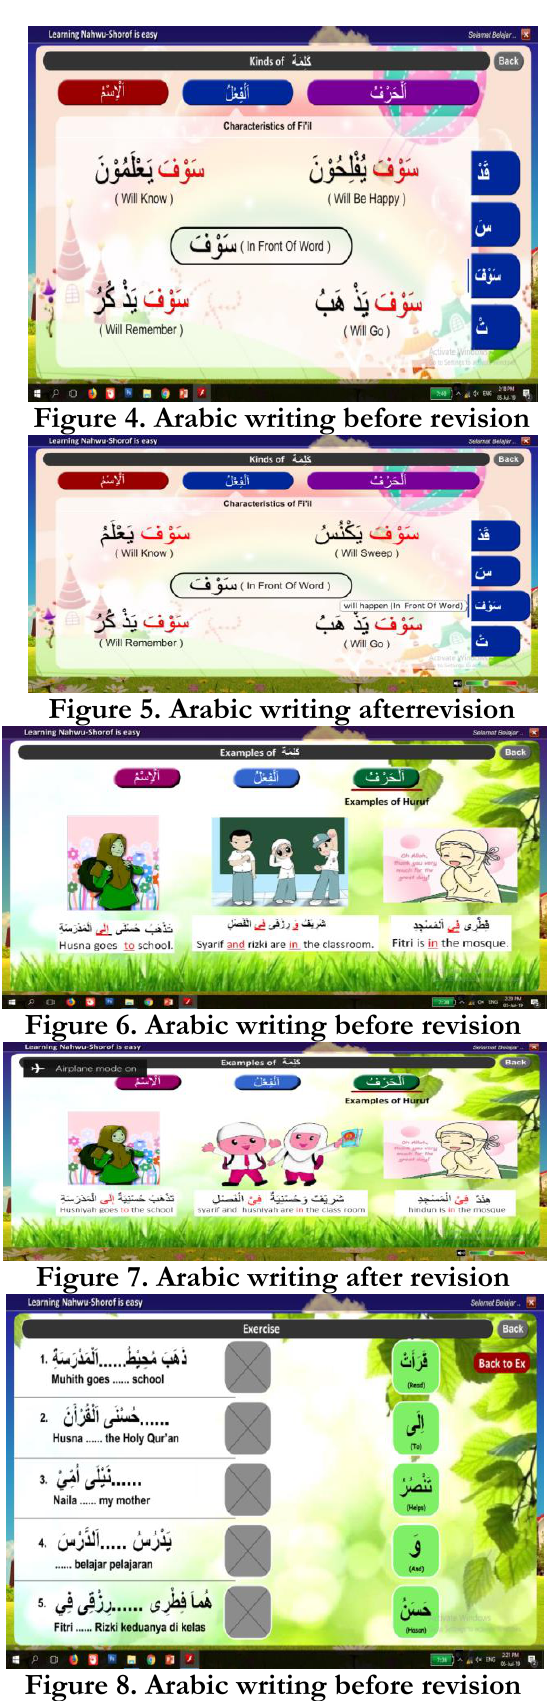
Figure 8. Arabic writing before